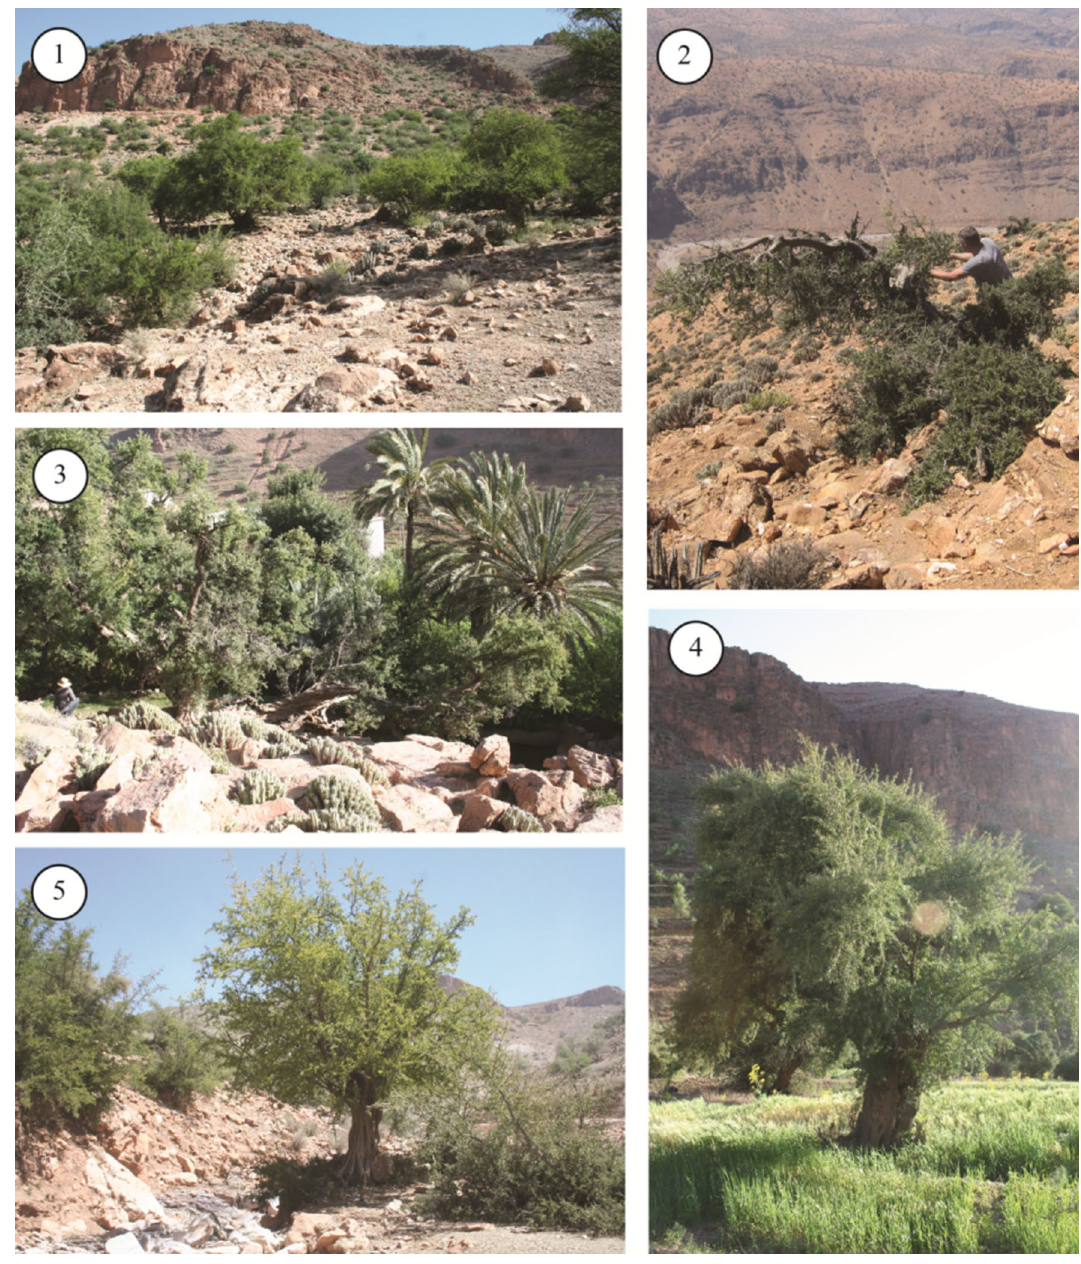
Figure 2. Different growing conditions and forms of the Argan tree in the study area: (1) Argan shrub-steppe; (2) Stunted small Argan tree frequently grazed by goats; (3) Argan tree in irrigated gardens; (4) Argan tree in a non-irrigated barley field; (5) Argan tree growing in a temporary stream bed (‘oued’) – All photographs were taken by J.-F. Terral and J.